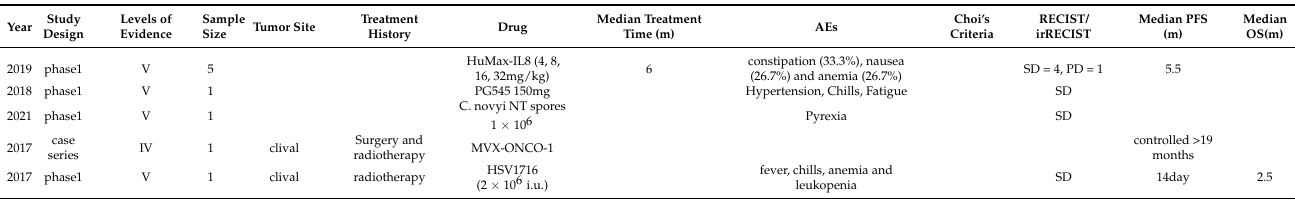
Table 4. Immunotherapy of chordomas with immunomodulatory